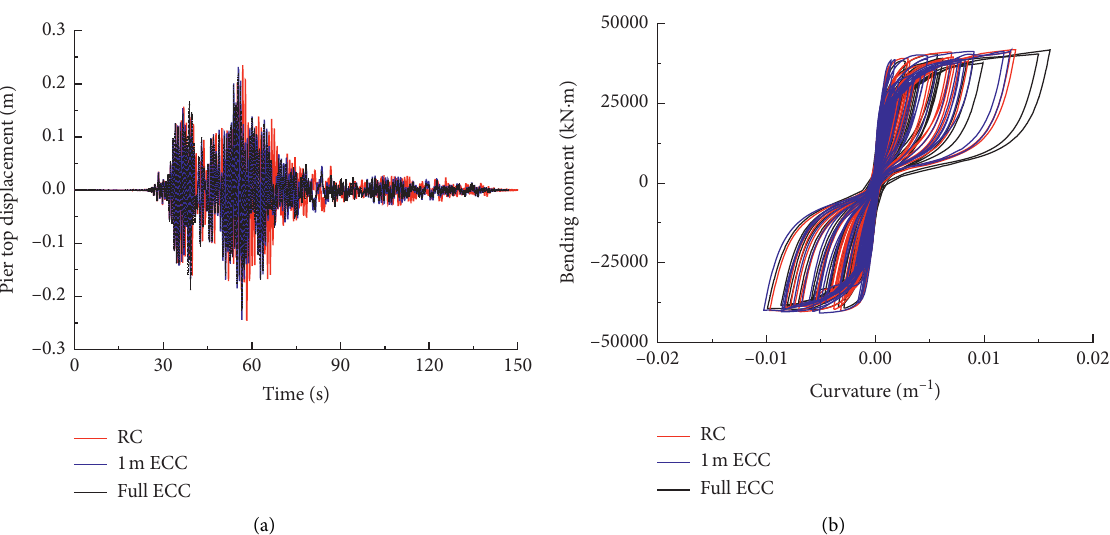
Figure 3: Seismic response of the piers: (a) time-history curve of pier top displacement and (b) moment-curvature hysteretic curve.